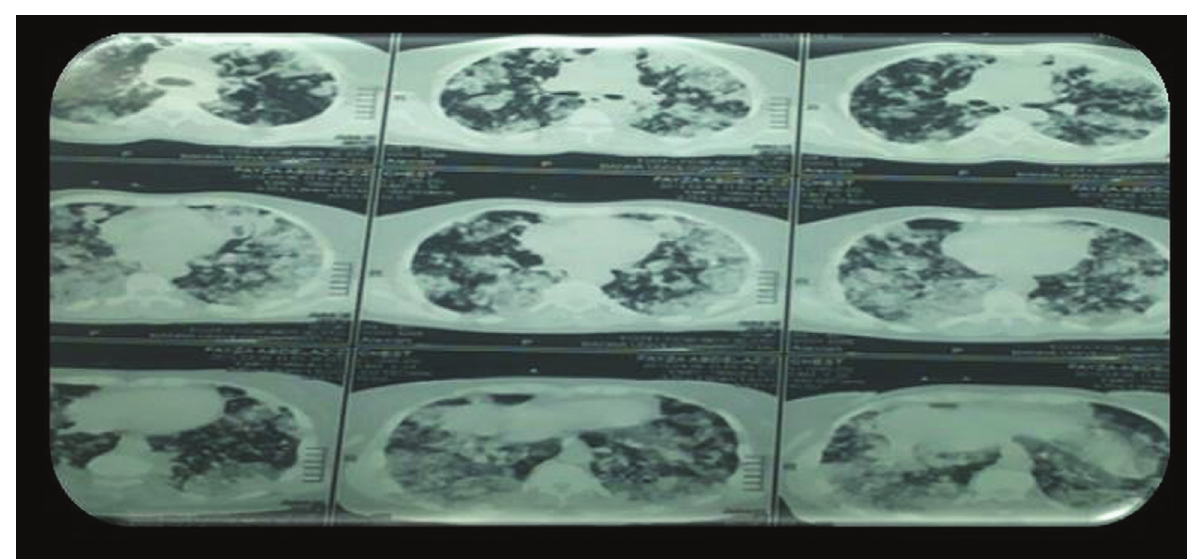
Computed tomography of chest with contrast revealed diffuse bilateral patchy infiltrations.